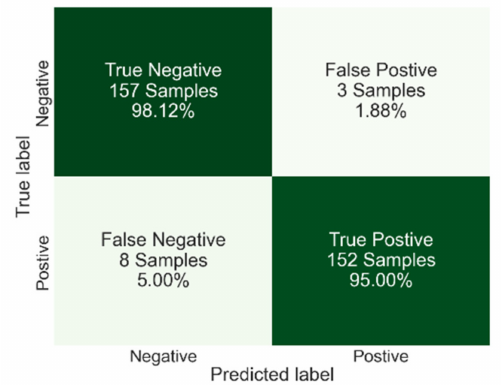
Figure 8. Confusion matrix results for DTC algorithm with an overall accuracy of